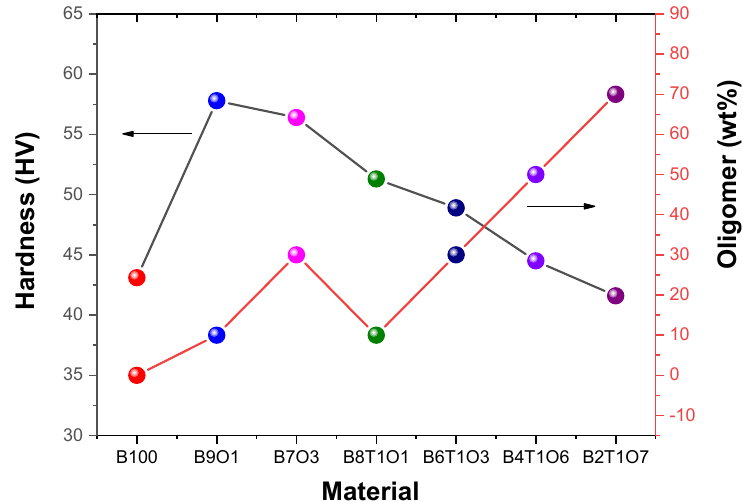
Figure 5. Surface hardness of the 3D-printed specimens. The values of the compression and compression modulus were the highest for the B100 specimen at 28.2 MPa and 733.2 MPa and the lowest for the B2T1O7 specimen at 15.6 MPa and 246.7 MPa. The values of the compression and compression modulus showed similar results (Figure 6).